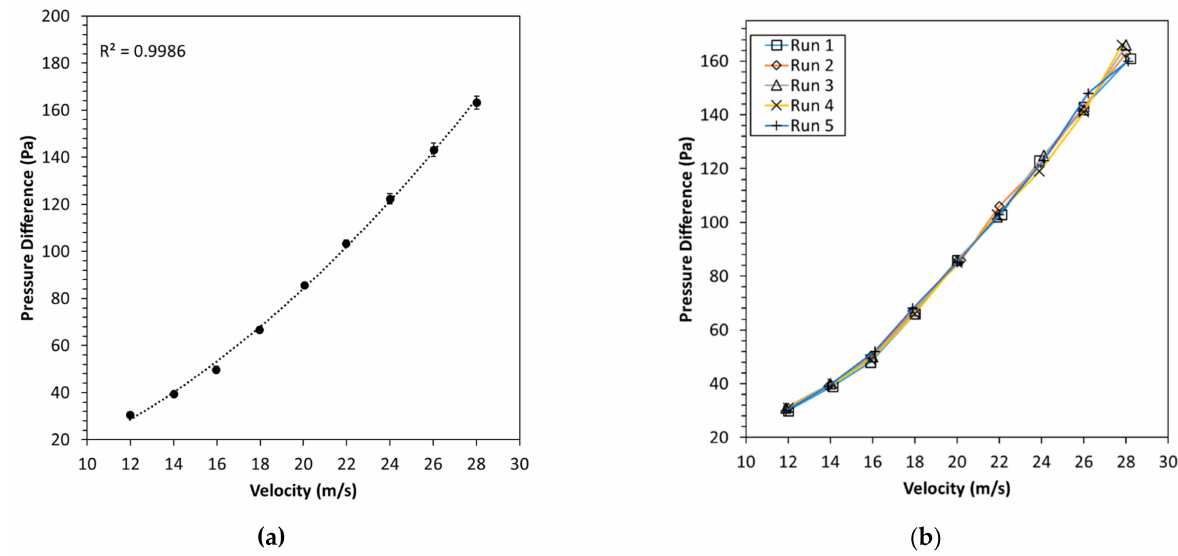
Figure 10. Experimental results for 6 mm dimples engraved on NACA/elliptical profile; ( a ) average of 5 runs; ( b ) 5 individ- ual runs.